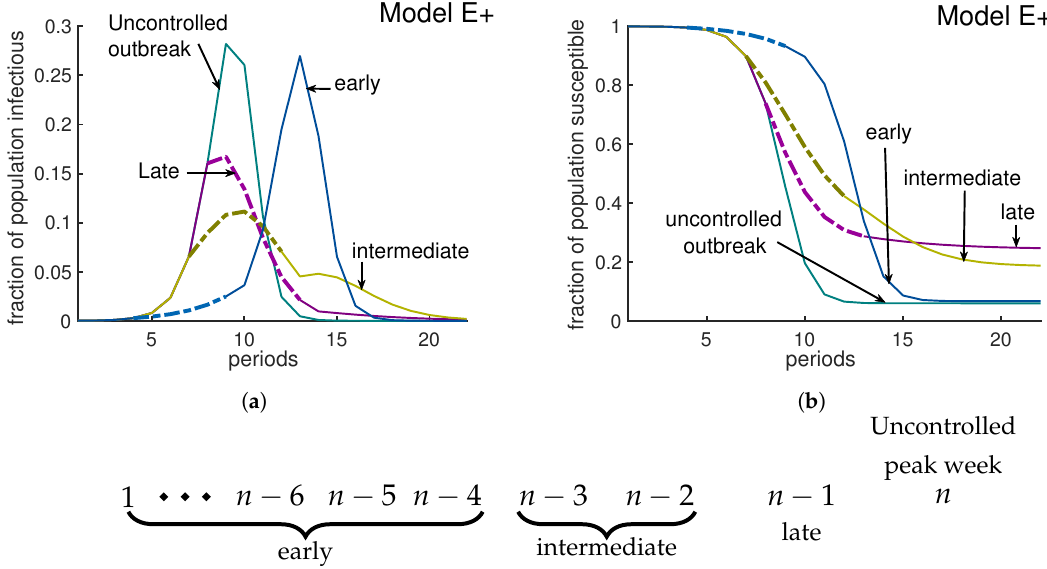
Figure 7. Timing an intervention for optimal effect. In this simulation, the rate of contact was β = 3 before and after intervention; during an intervention β ∗ = 1.6. The green curves represent the uncontrolled outbreak without any intervention; the peak is about 28% and S final is about 6%. Panel ( a ) represents the fraction of infectious individuals and panel ( b ) shows the susceptible fraction of population. Here we have implemented three different 6-week long interventions. An early intervention (blue curves) that starts at week 5 is not very interesting compared to an intermediate